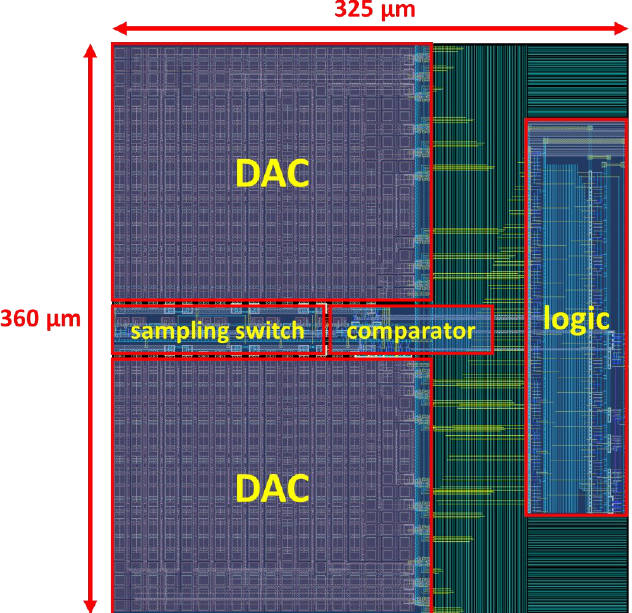
Figure 16. Layout of the ADC.